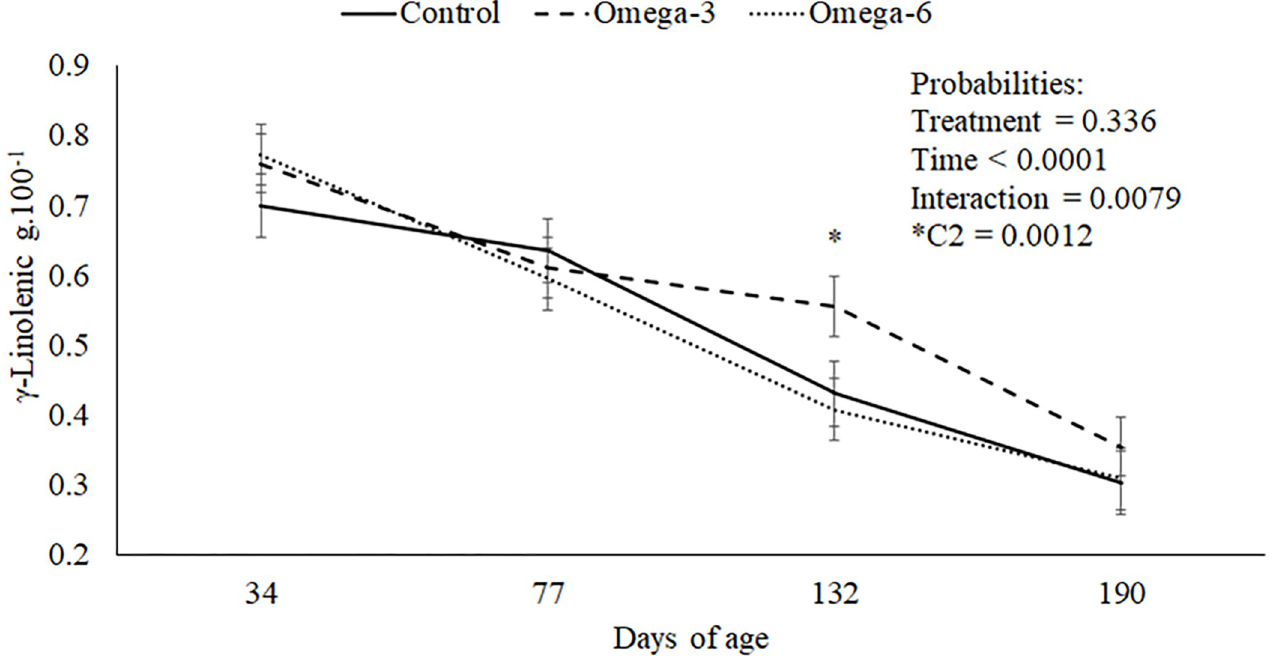
Fig 2. γ -linolenic tends to have a higher concentration in n-3 treatment at 132 days of age of gilts.